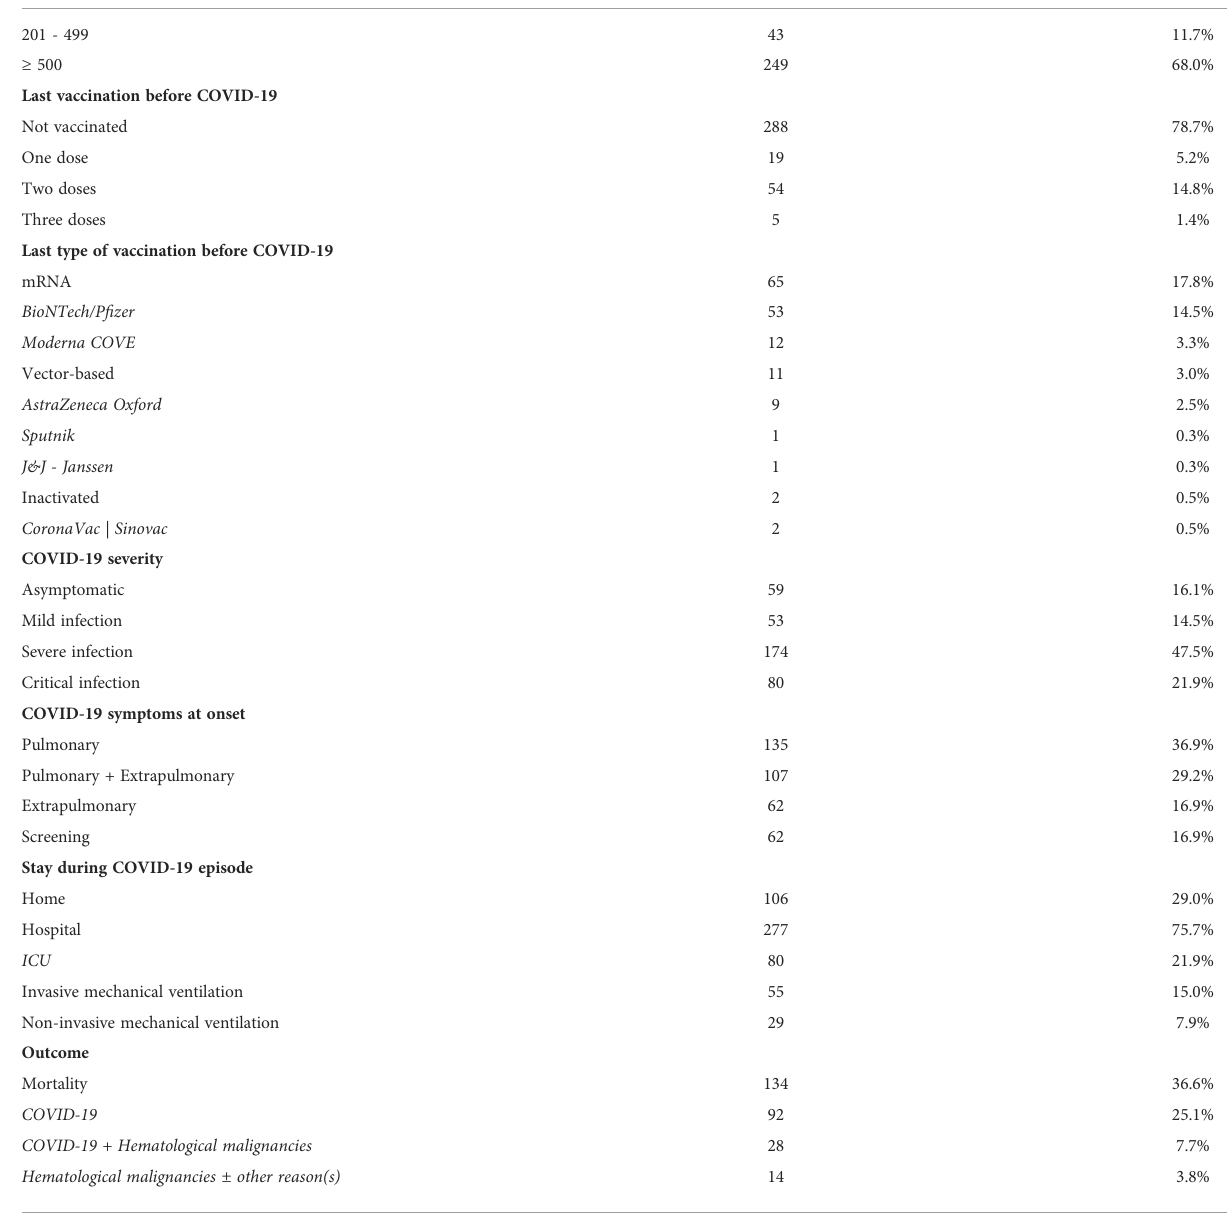
Factors associated with severe COVID-19 Severe COVID-19 was observed in 47.5% (n=174) of patients, including 21.9% (n=80) who were admitted to intensive care unit (ICU). Among the latter, 55 (68.8%) were CLL patients, and 25 (31.3%) were non-Hodgkin lymphoma (NHL) patients. Fifty- fi ve (44%) of the ICU-admitted patients underwent invasive mechanical ventilation. The median ICU stay in the entire cohort was 9 days (IQR 2-50, range,